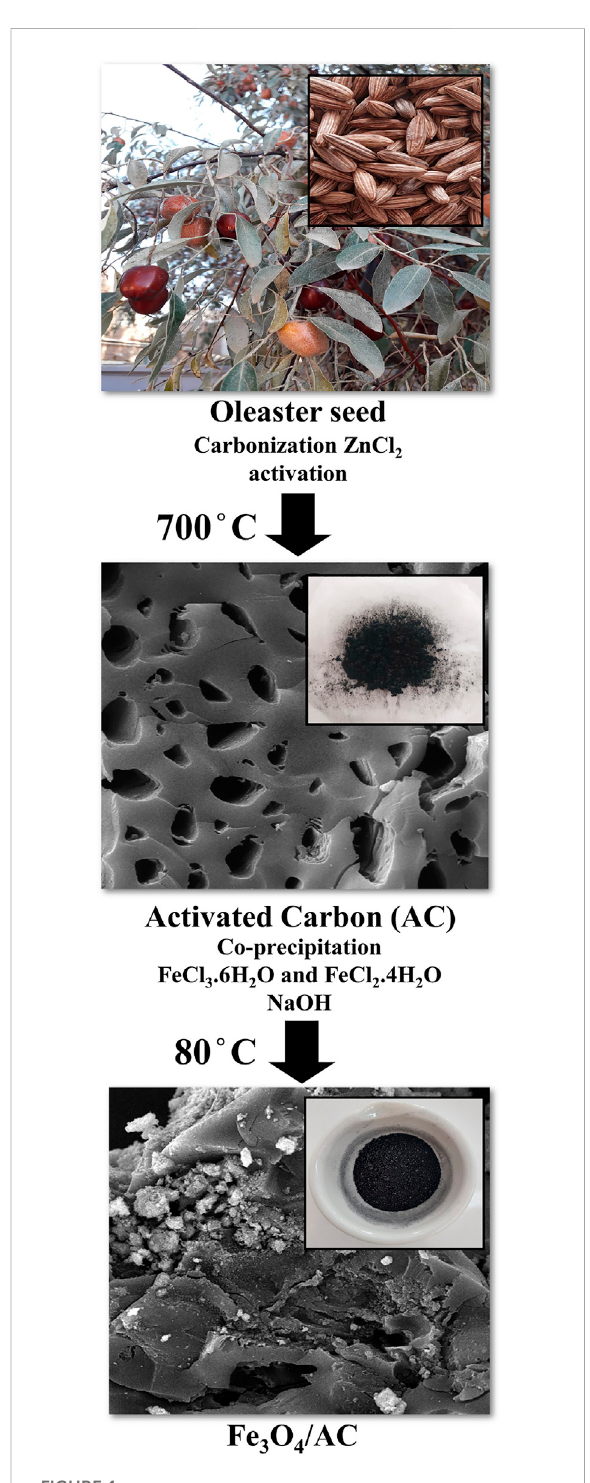
FIGURE 1 Schematic illustration of the fabrication of Fe 3 O 4 /Activated Carbon (AC)